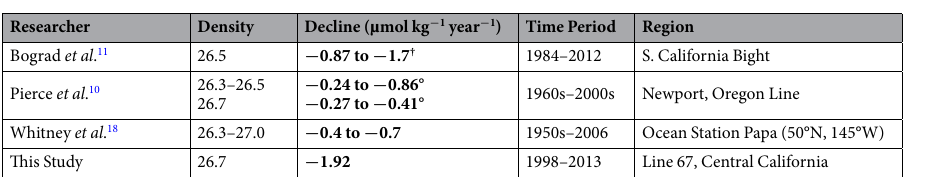
Table 1. Summary and comparison of rates of decline in the California Current and Northeast Pacific. † Derived from Fig. 3 in Bograd et al . 11 . °Taken from Table 1 in Pierce et al . 10